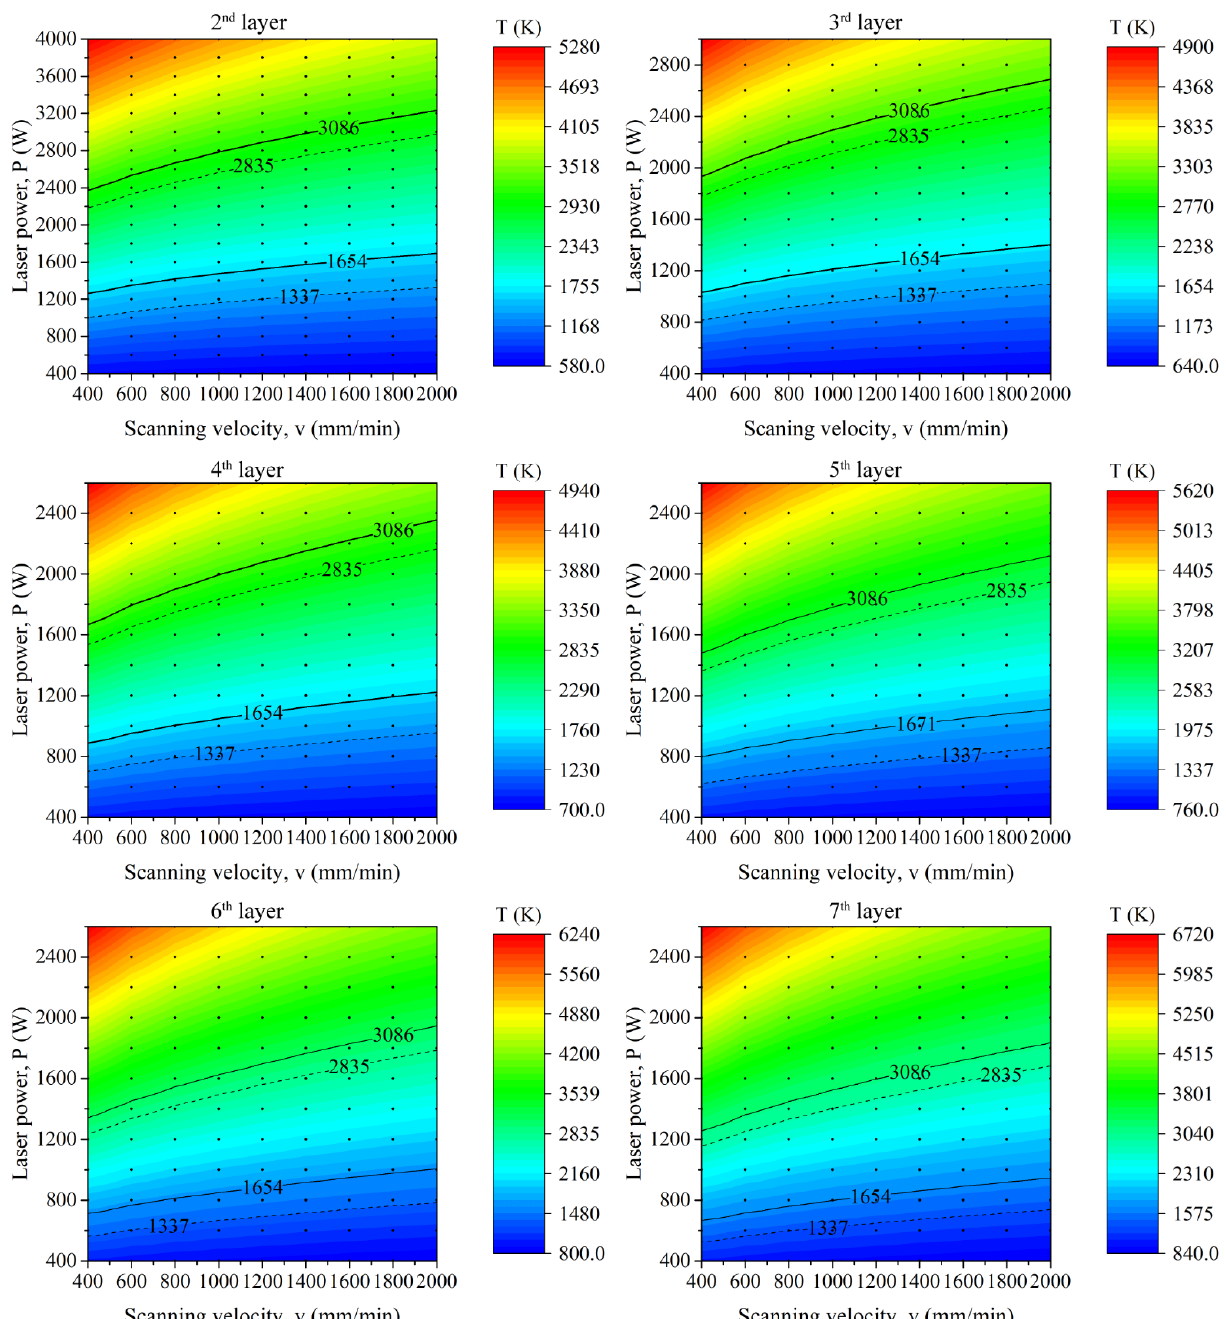
Figure 8. The peak temperature of different parameters for the 2nd to 7th layers.